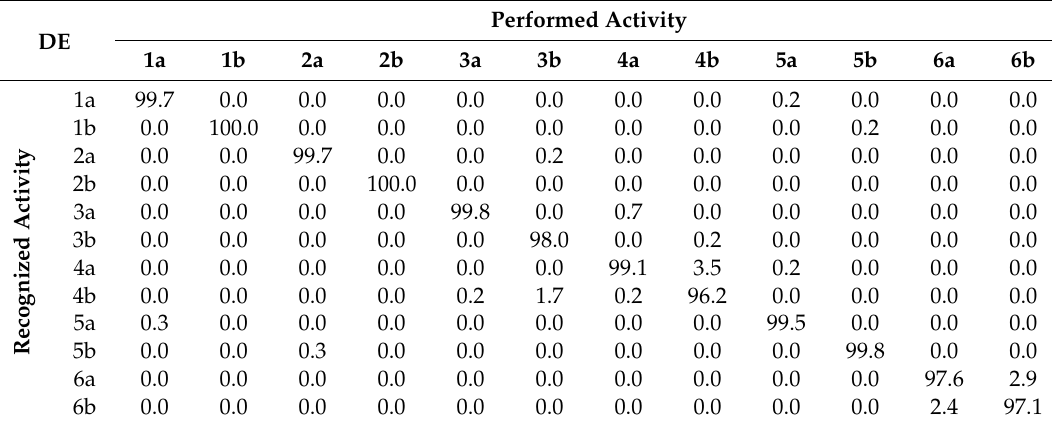
Table A6. Matrix of recognition errors (in %) of 12 motor activities 1a ÷ 6b in test set for all volunteers together for sensor